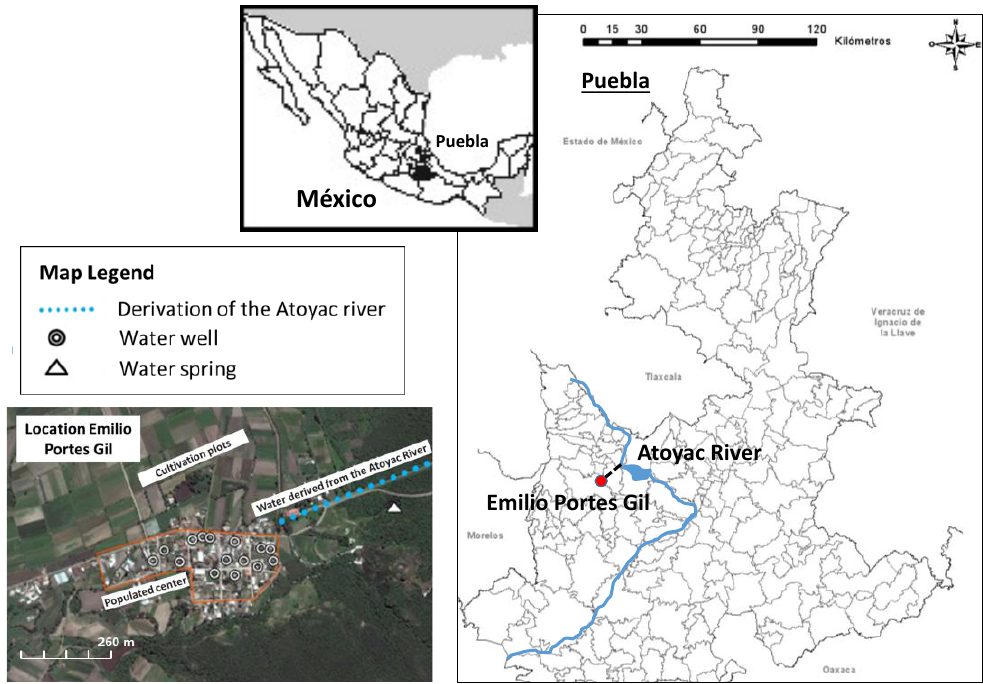
Figure 1. Study area, indicating the groundwater sources sampled in the agricultural town Emilio Portes Gil (Puebla, México).